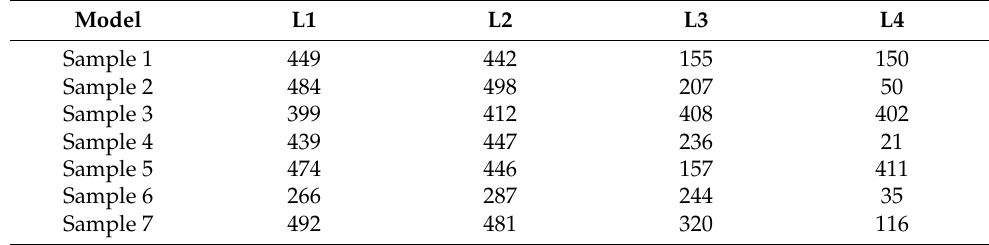
Table 5. Optimized number of neurons in intermediate layers for each tactile sensation estimation